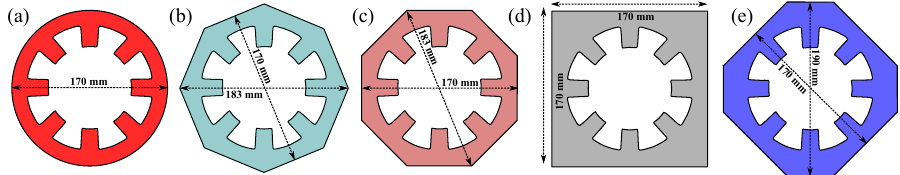
Figure 15. Stator yokes designs: ( a ) Baseline, ( b ) Octagon I, ( c ) Octagon II, ( d ) Square,